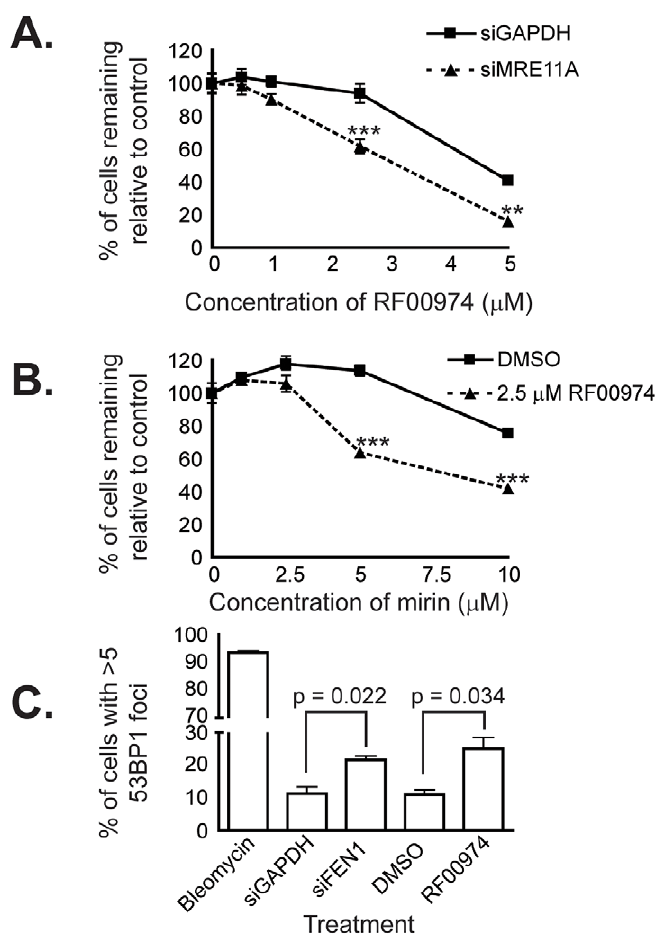
Figure 6. RF00974 recapitulates the interaction between FEN1 and MRE11A , and leads to increased endogenous DNA damage. (A) siRNA-mediated knockdown of MRE11A sensitizes HCT116 cells to treatment with RF00974. siRNA transfection experiments were carried out as described in Materials and Methods. Cells were fixed and imaged four days following siRNA transfection, after cells had been incubated in compound for 48 hours. Data were analyzed by one-way ANOVA followed by a Tukey test. Shown is mean 6 SEM. * p , 0.05; ** p , 0.01; *** p , 0.001. (B) Chemical inhibition of MRE11A sensitizes cells to RF00974. Cells were incubated in the indicated compounds at the indicated concentrations for three days prior to fixation and imaging as described in Materials and Methods. Data were analyzed by one-way ANOVA followed by a Tukey test. Shown is mean 6 SEM. * p , 0.05; ** p , 0.01; *** p , 0.001. (C) Inhibition of flap endonuclease activity with RF00974 mimics siRNA-mediated knockdown of FEN1 by increasing endogenous DNA damage. Data were analyzed by Student’s t test. Shown is mean 6 SEM.